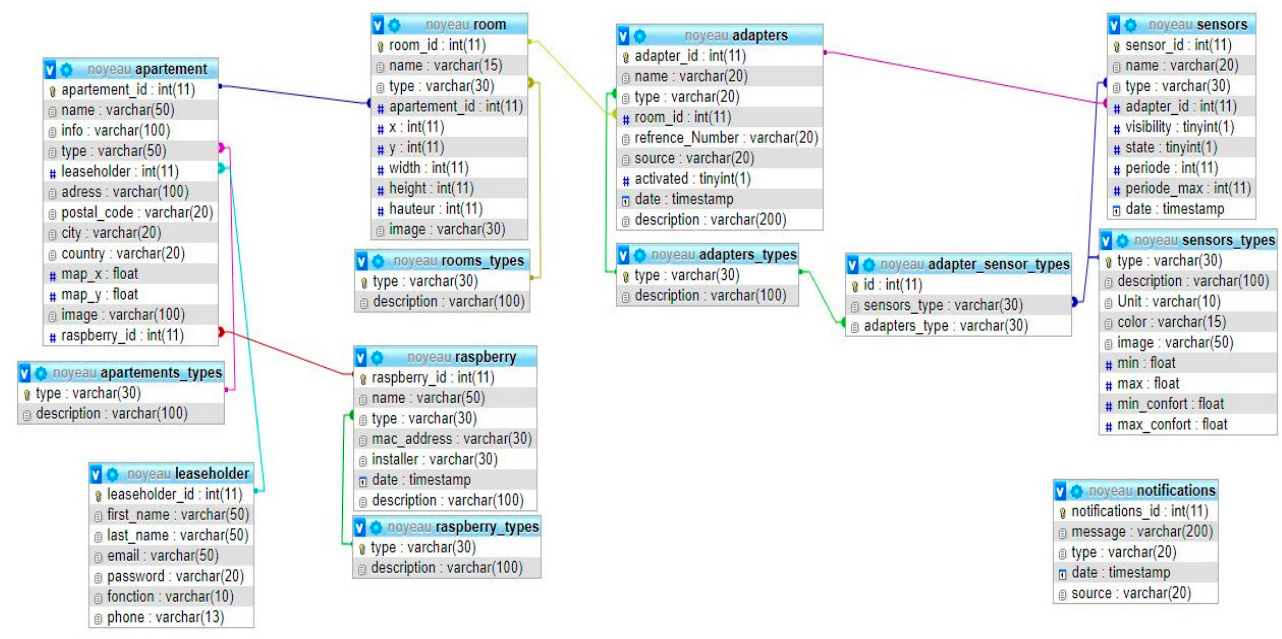
Figure 9. Database Structure.